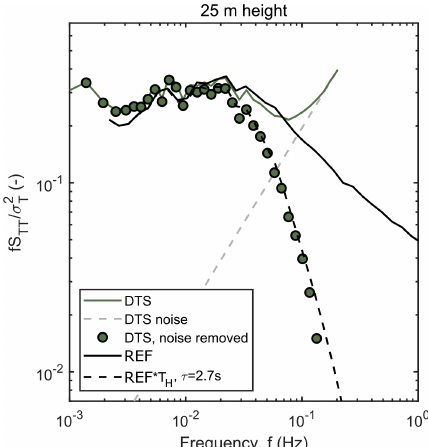
Figure 3. Ensemble-averaged, frequency-weighted and normalised temperature power spectrum estimated from the DTS data and co- located 3D sonic anemometer (reference – REF) at 25m height above ground (1.5 h c , where h c is canopy height). Only periods with high DTS SNR and moderate wind speed (between 1.7 and 3.3ms − 1 ) were selected for the ensemble. The DTS power spec- trum is shown before and after the noise removal procedure, and the high-frequency attenuation is demonstrated by multiplying the reference power spectrum with a transfer function (Eq. 5).